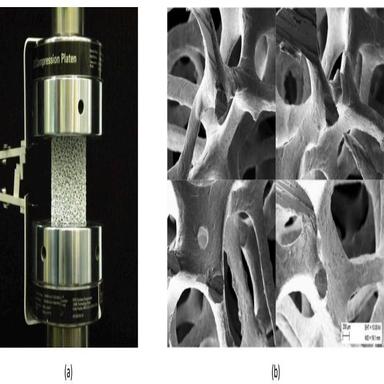
(a) Compression test performed on the specimen of open-cell foam Al 6101-T6 Duocel® 10 PPI. (b) SEM magnifications of the specimen.